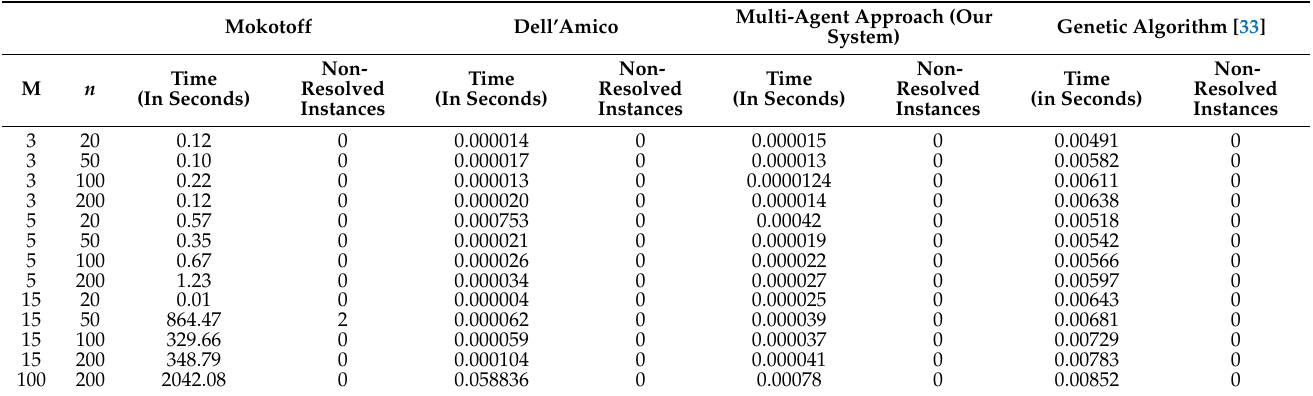
Table 2. Results for large number of instances of DellAmico and E. Mokotoff.